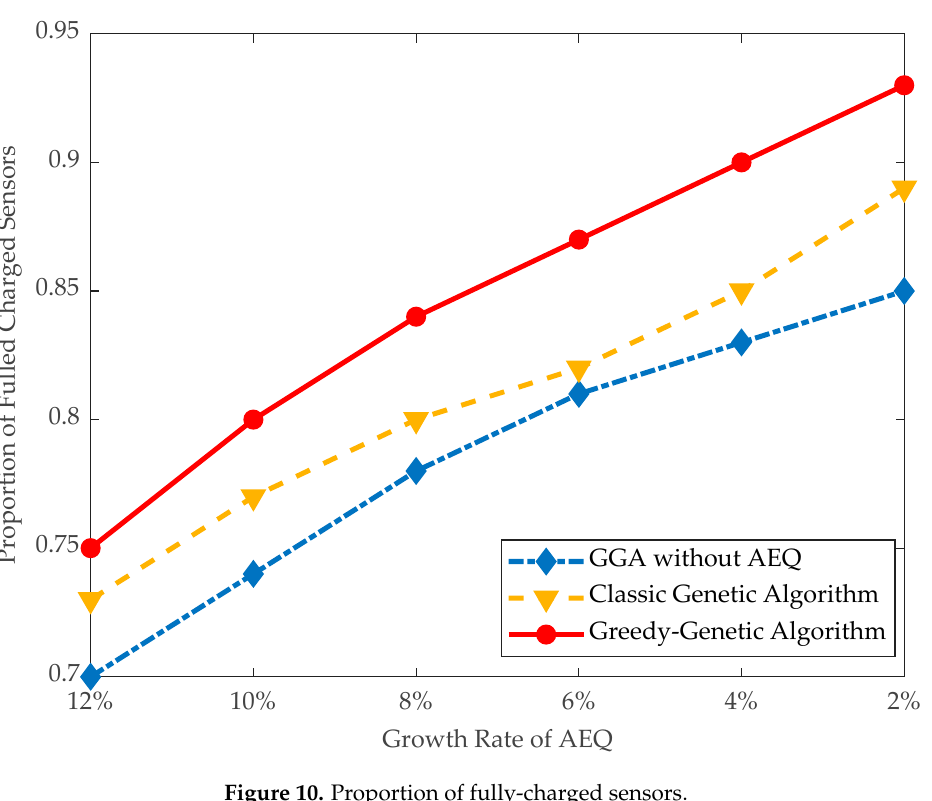
Figure 10. Proportion of fully-charged sensors.